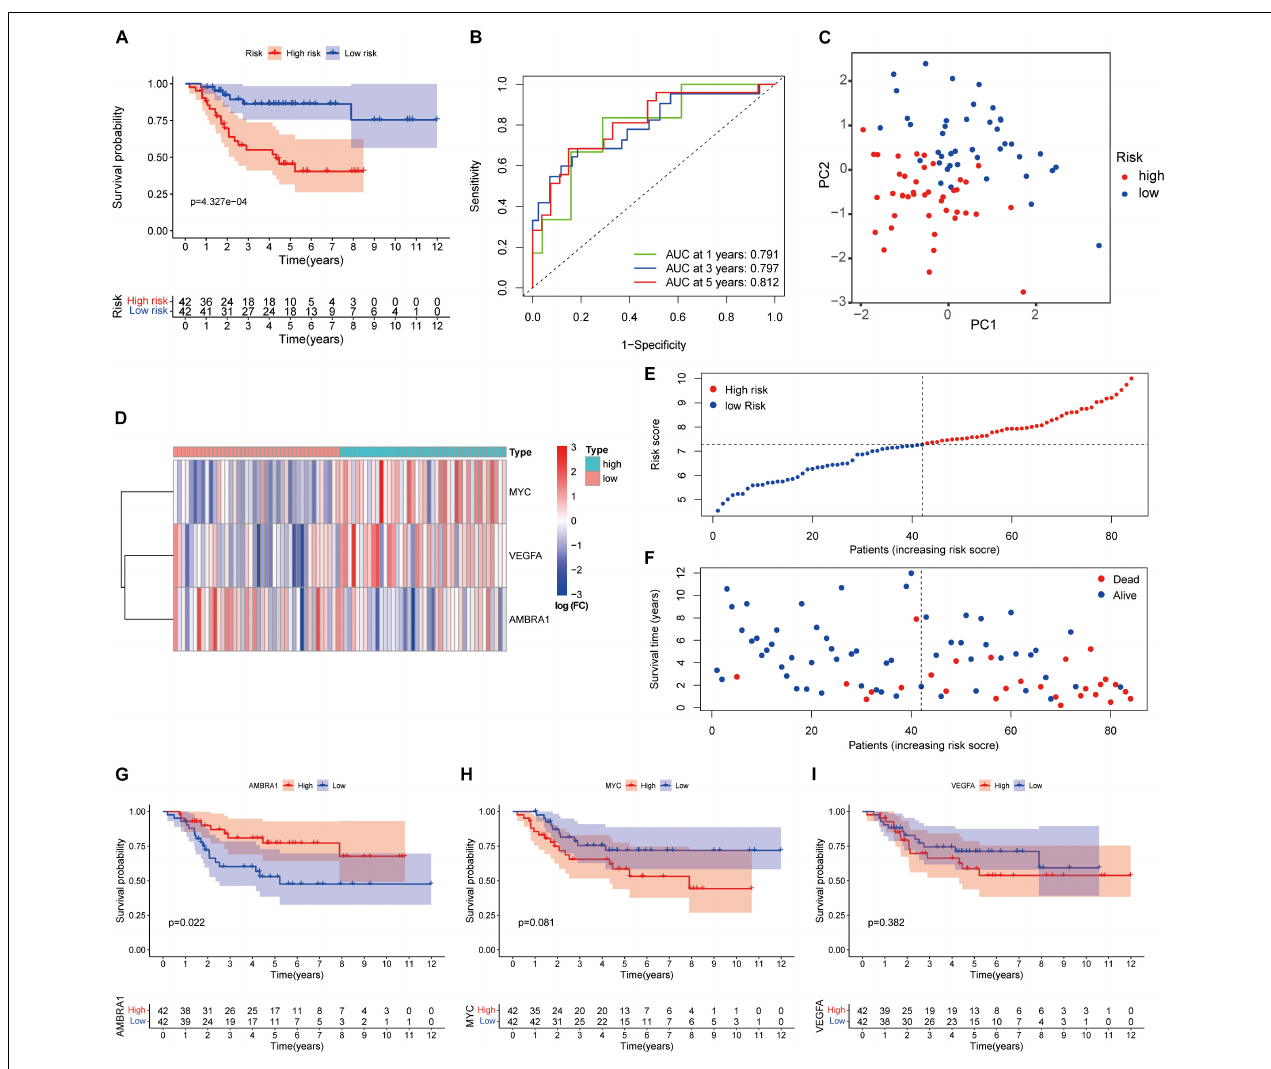
FIGURE 6 | Autophagy-related genes (ARGs) signature based on TARGET. (A) Kaplan–Meier curves result. (B) The AUC for the prediction of 1, 3, 5-year survival rate of osteosarcoma. (C) PCA based on the confirmed three ARGs signature. (D) Heatmap of the key genes expressed between the high and low risk group.